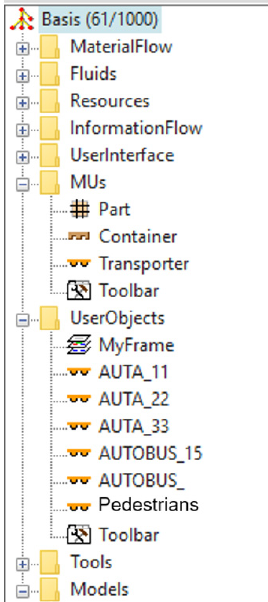
Figure 5. Example of a library in Tecnomatix Plant Simulation.